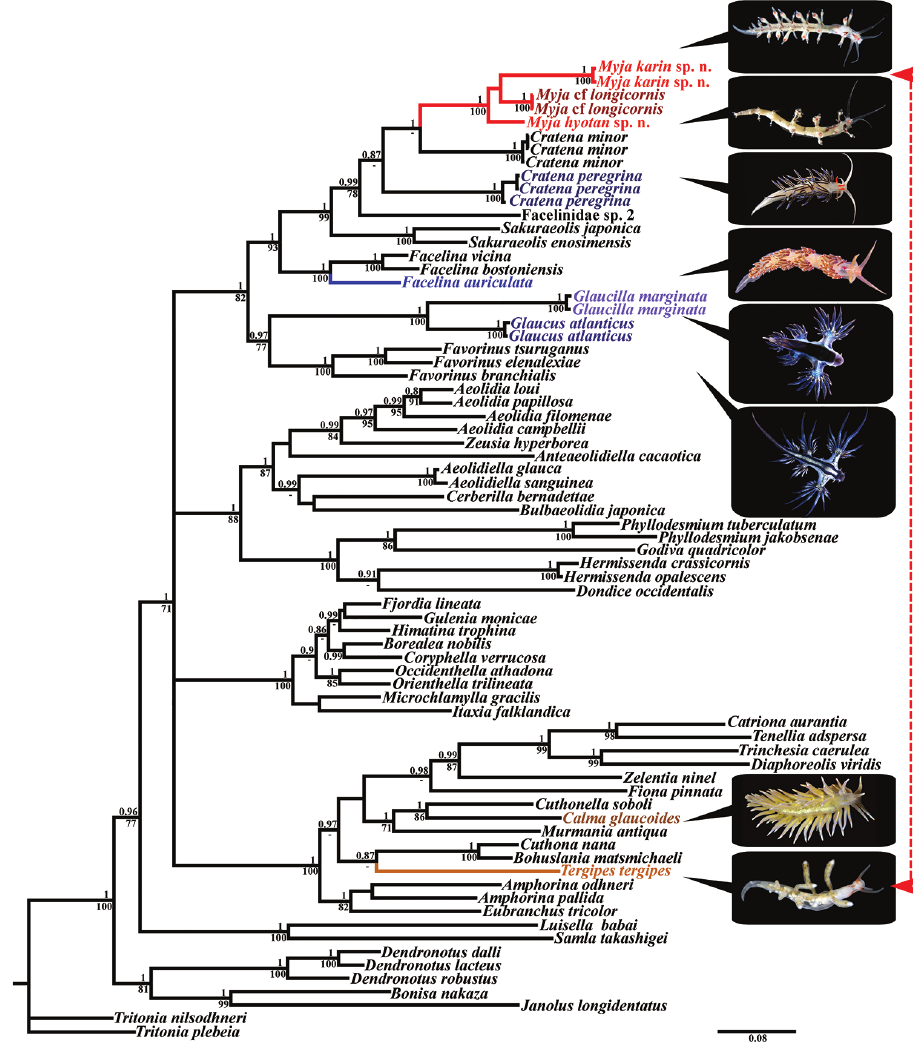
Figure 5. Phylogenetic tree of aeolidacean nudibranchs based on concatenated molecular data (COI + 16S + H3) represented by Bayesian Inference (BI). Numbers above branches represent posterior prob- abilities from Bayesian Inference. Numbers below branches indicate bootstrap values for Maximum Like- lihood. The key clades and illustrated taxa are highlighted in colour. Two taxa with highly convergent external morphology but very distantly related according to the molecular analysis, the Tergipedidae and the genus Myja , are connected by a dotted red line. Neotype ZMMU Op-669 of Facelina auriculata (Mül- ler, 1776) is illustrated on the tree (photograph BE